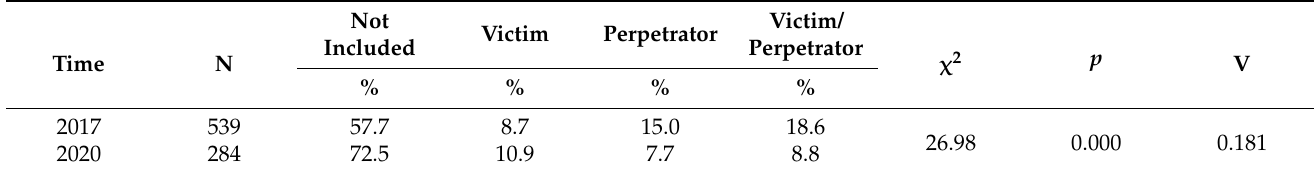
Table 3. The comparison of the violence by role.